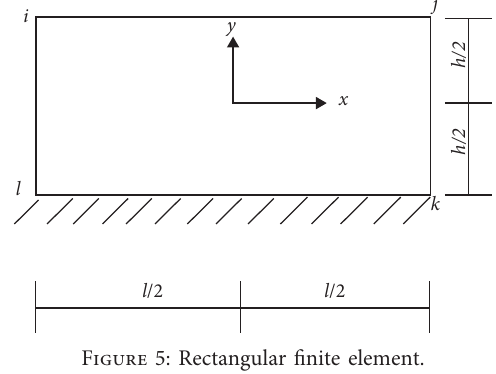
Figure 5: Rectangular finite